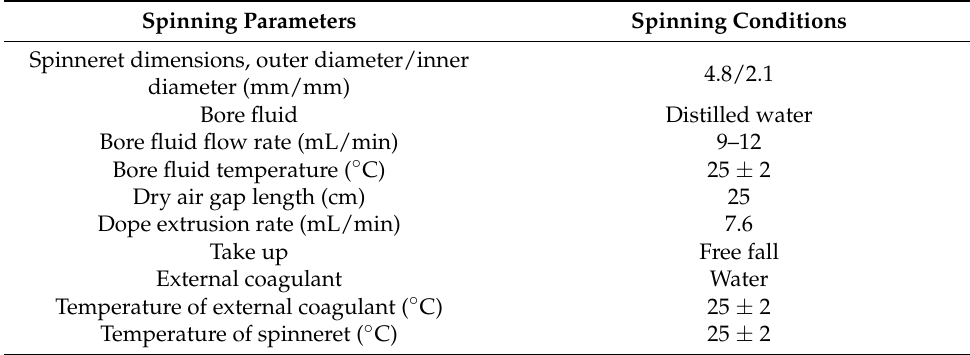
Table 1. Spinning parameters for polyetherimide (PEI) hollow-fiber fabrication.